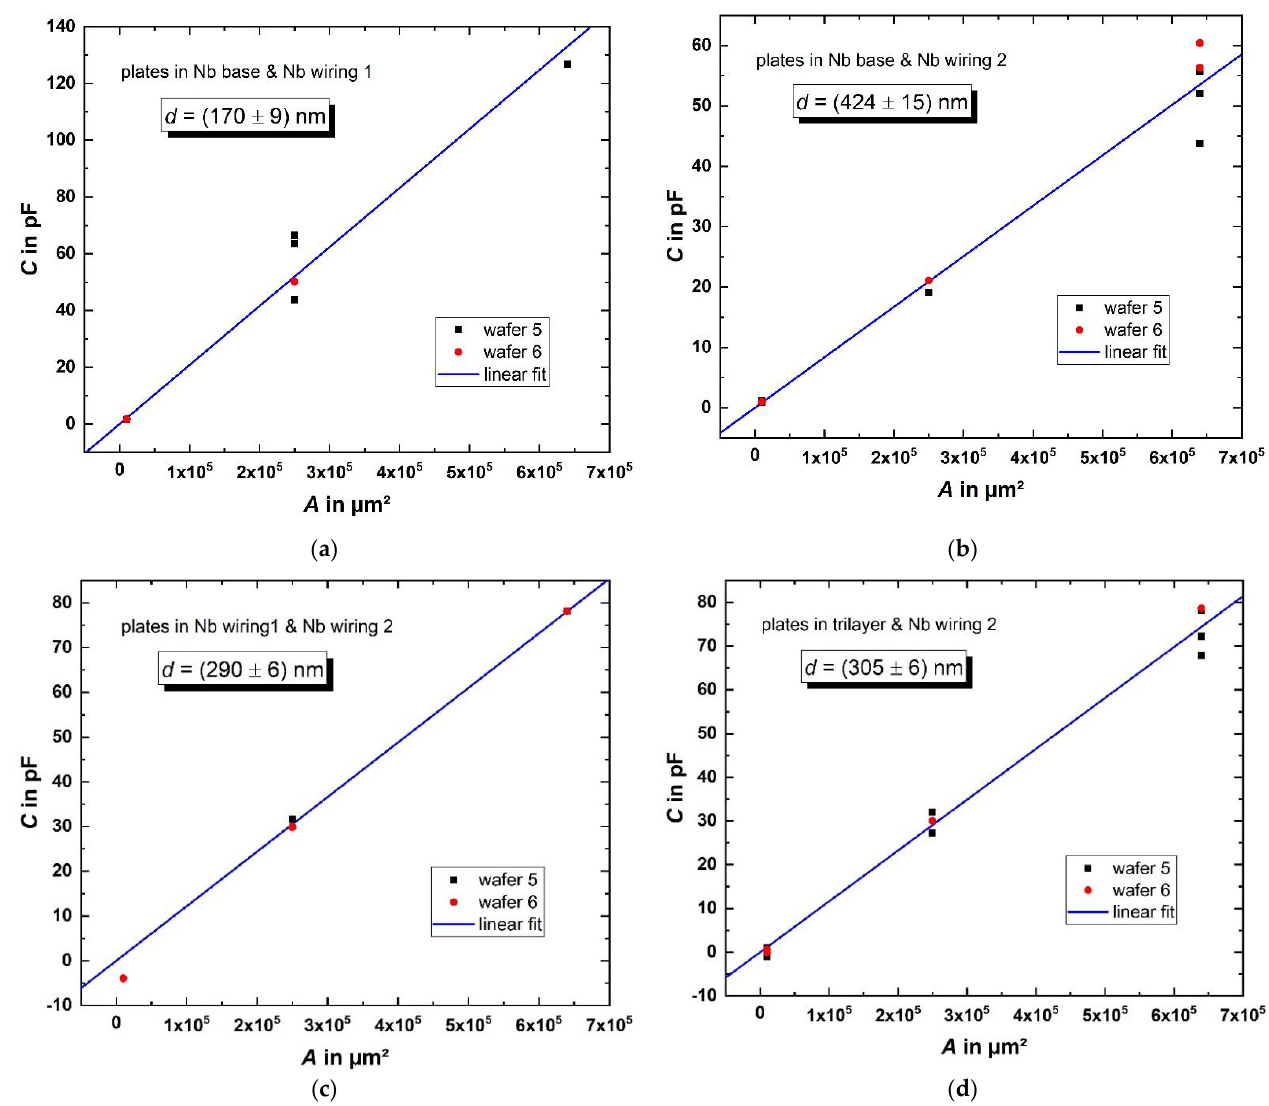
Figure 7. Measured capacitances (corrected values) of capacitors (corresponding to Figure 6) on wafers 5 and 6 with different sizes (100 µm × 100 µm … 800 µm × 800 µm). The thickness of the dielectric layers was calculated according to Equation (1) from the fit parameters for capacitors with plates in the Nb base and first wiring layer ( a ), in the Nb base and second wiring layer ( b ), in the two wiring layers ( c ) and in the trilayer and second wiring layer ( d ). The effective SiO 2 thickness between the different capacitors with plates in the Nb base layer and the first Nb wiring layer (Figure 7a) is d = (170 ± 9) nm. For